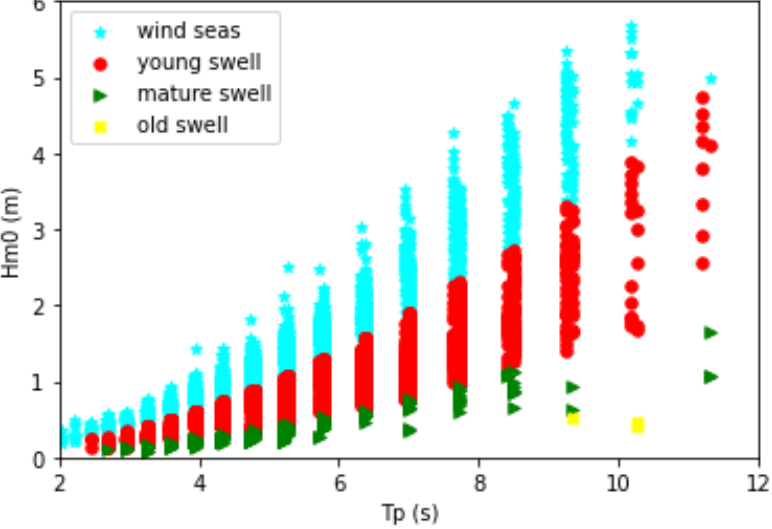
Figure 14. Discrimination of subsets of data (5_sf) corresponding to salient formation into wind seas and swells of different age, based on the wave steepness